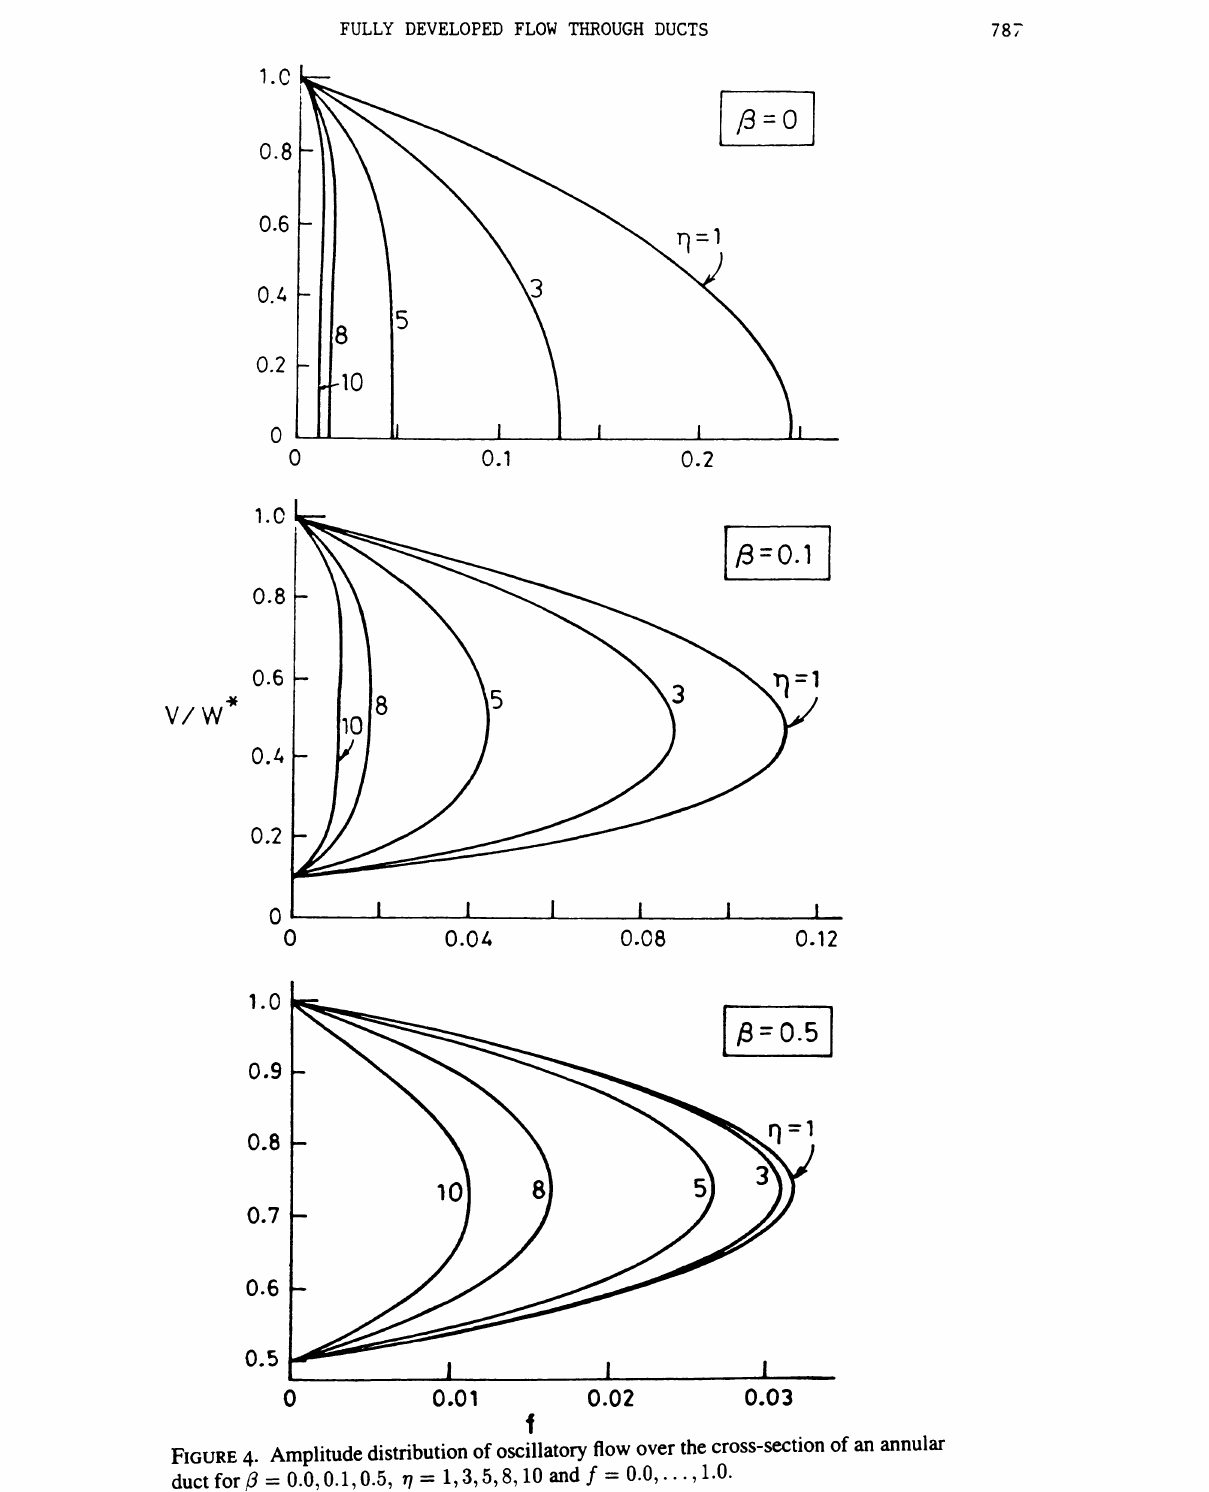
P’[GURE 4- Amplitude distribution of oscillatory flow over the duct for/ 0.0,0.1,0.5, /= 1,3,5,8,10 and jr 0.0,...,